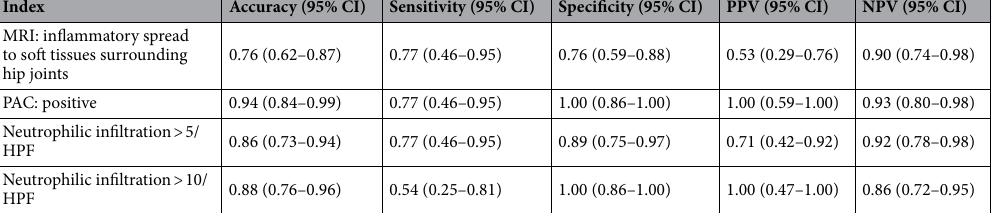
Table 6. Diagnostic accuracy of the tests of infection. CI Confidence interval, MRI Magnetic resonance imaging, NPV Negative predictive value, PAC Preoperative joint aspiration culture, PPV Positive predictive value, WBC White blood